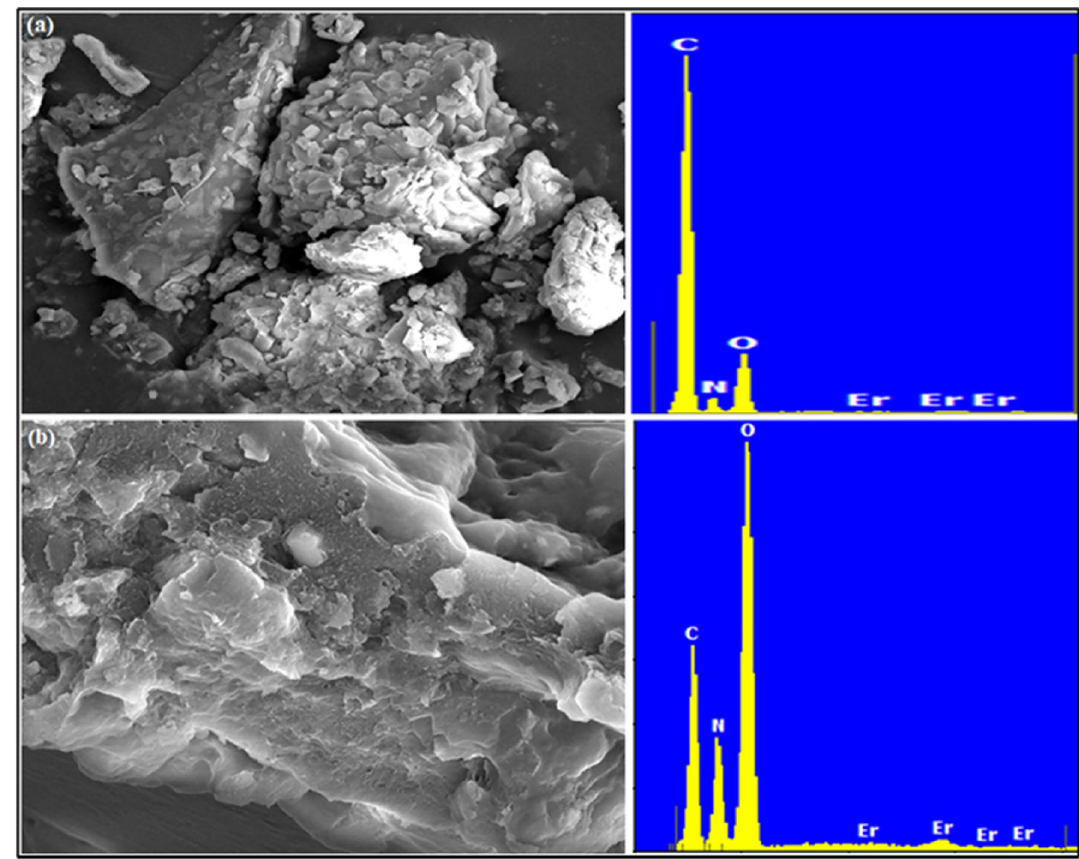
Figure 3. SEM micrographs of ( a ) GG-PAAm/Er 2 O 3 nanocomposite, and ( b ) NB-loaded nanocomposite along with corresponding EDX